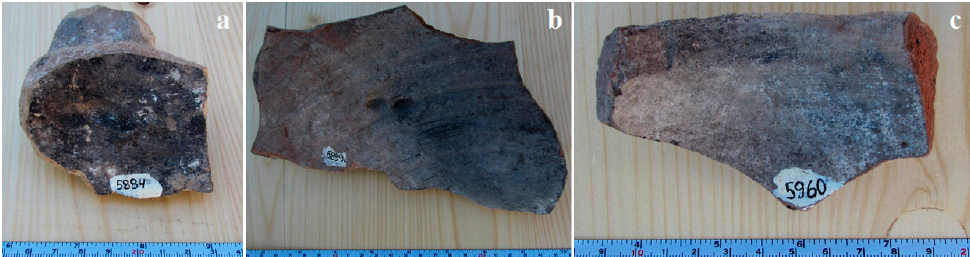
Figure 2. Amphora fragments: ( a ) Sample 1, ( b ) Sample 2 and ( c ) Sample3.